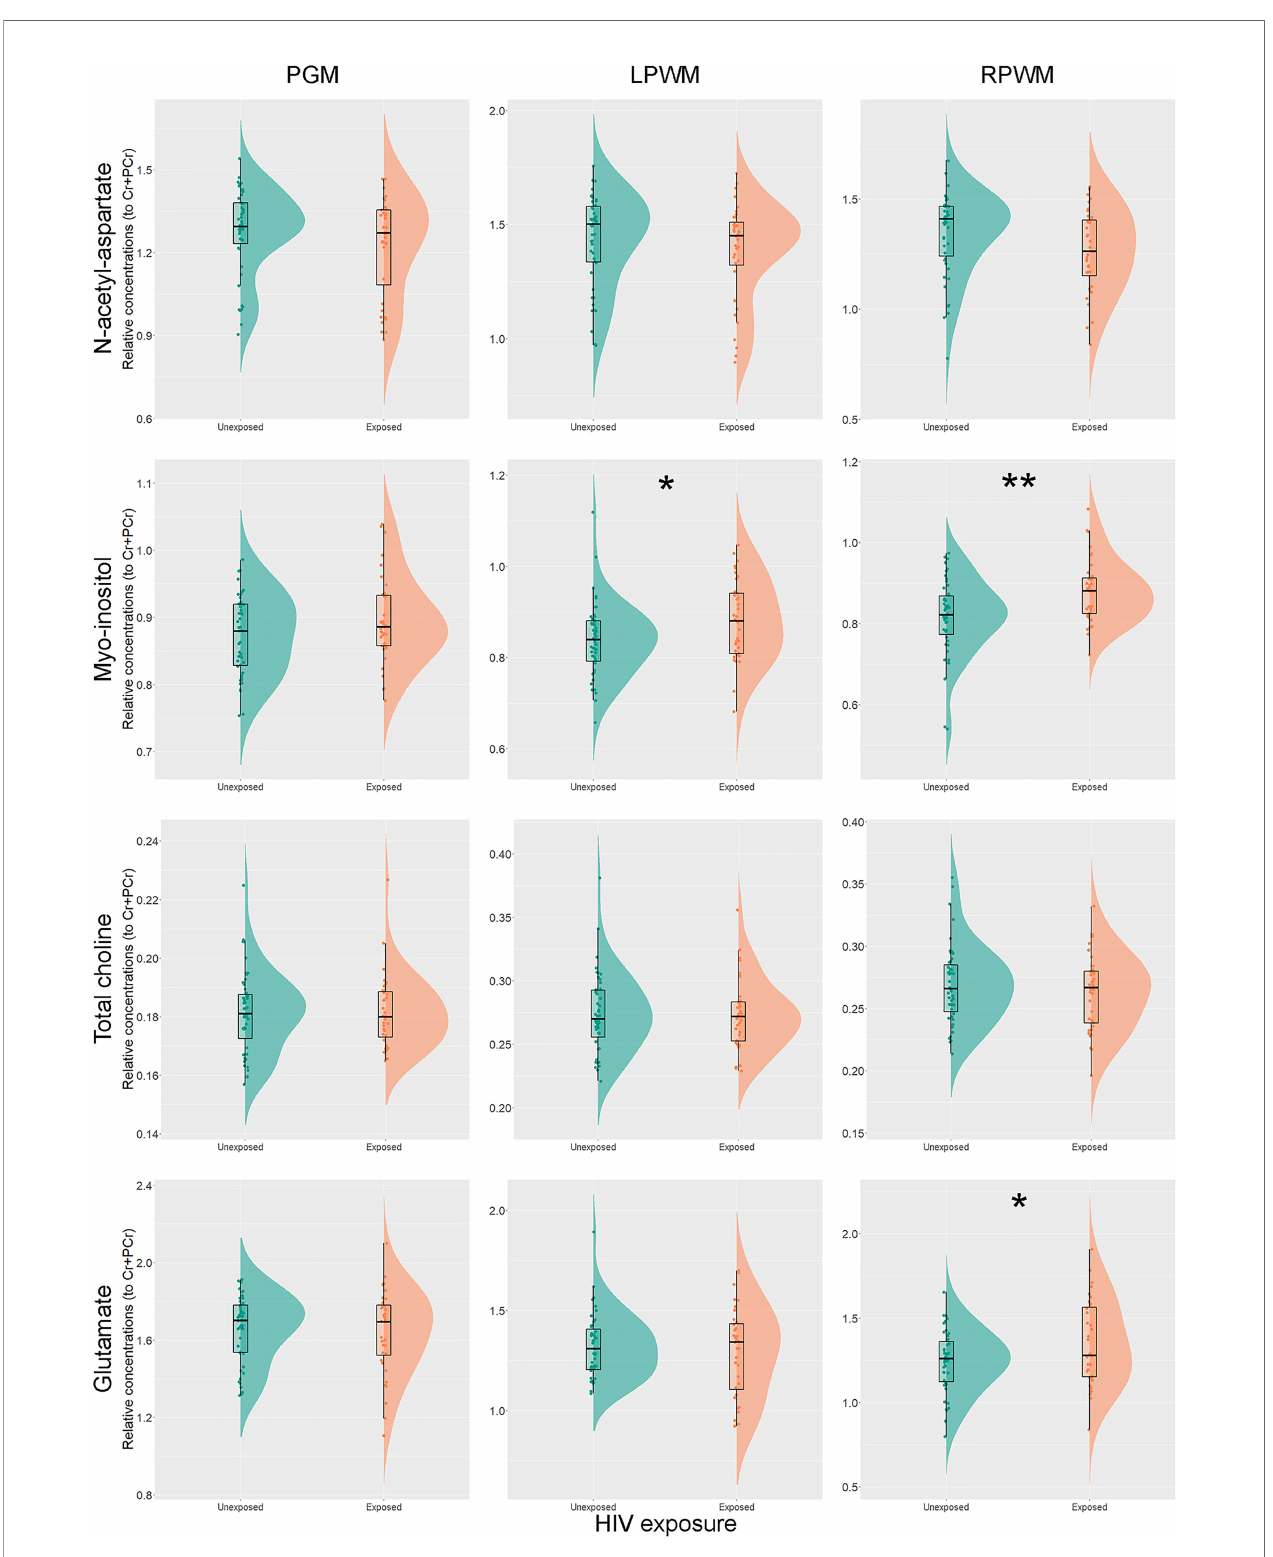
FIGURE 3 | Individual metabolite relative concentrations. Raincloud plots (54) showing individual metabolite relative concentrations to total creatine in the parietal grey matter (PGM), left parietal white matter (LPWM) and right parietal white matter (RPWM) in our complete-case cohort, according to HIV exposure. *p<0.05;